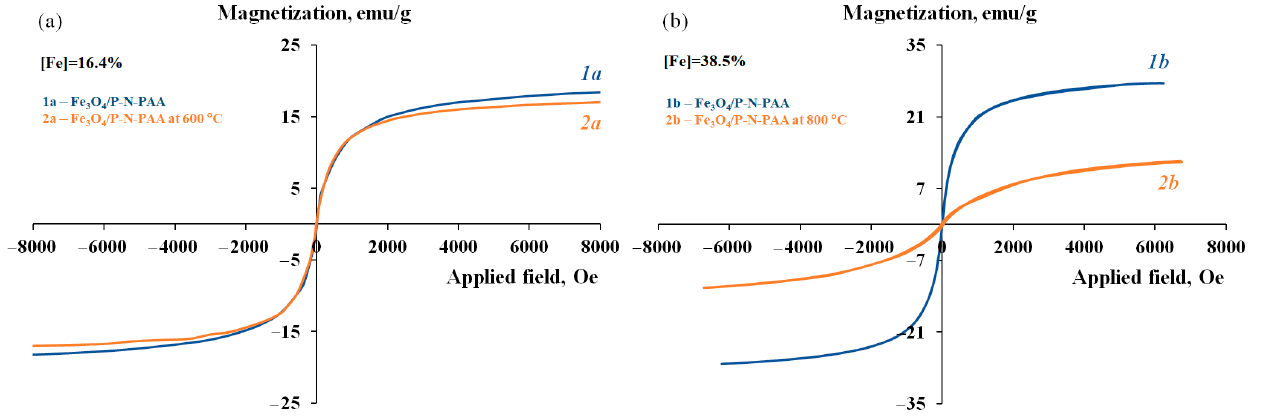
Figure 12. Magnetization of Fe 3 O 4 /P-N-PAA ( 1a , 1b ) and Fe 3 O 4 /P-N-PAA, IR heated at 600 ◦ C ( 2a ) and 800 ◦ C ( 2b ), as a function of applied magnetic field.